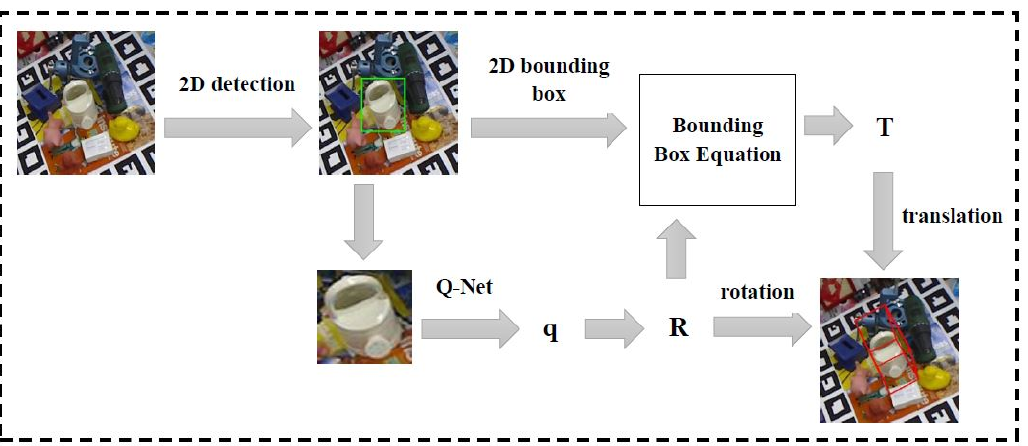
Figure 1. The Flow diagram of our approach.